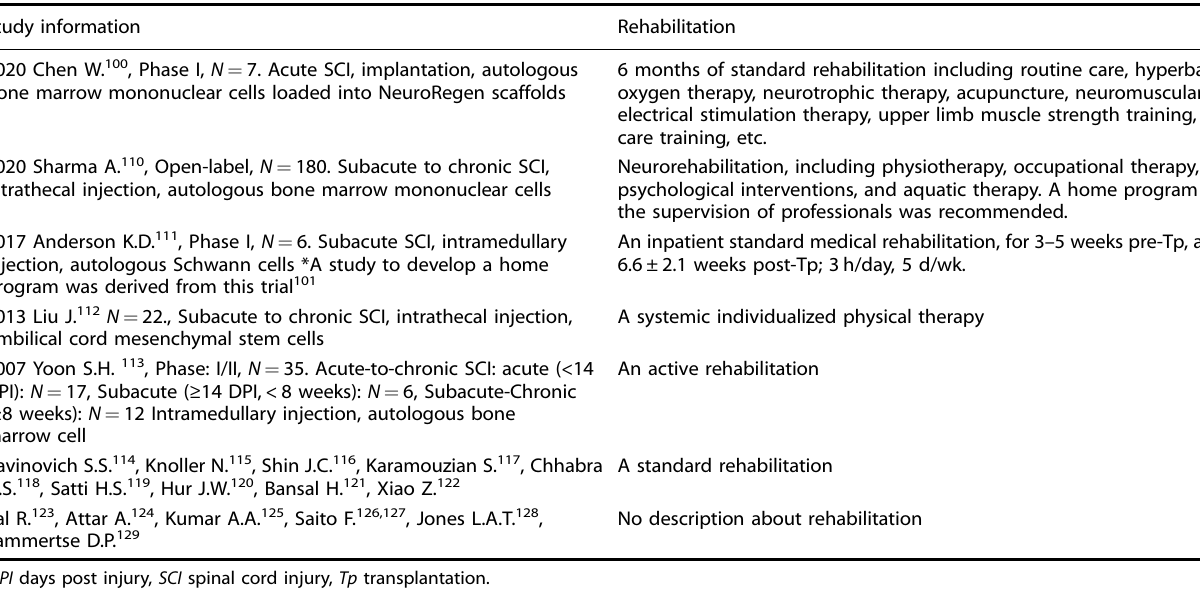
Table 2. SCI rehabilitation in clinical studies on stem cell therapies involving acute/subacute patients. Study information